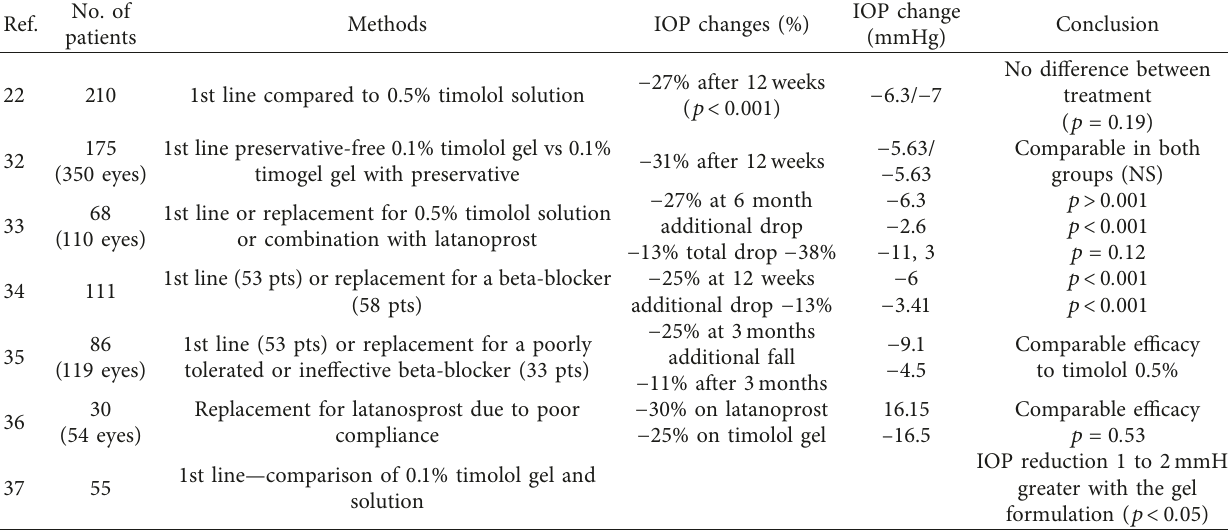
Table 1: Therapeutic efficacy of 0.1% timolol